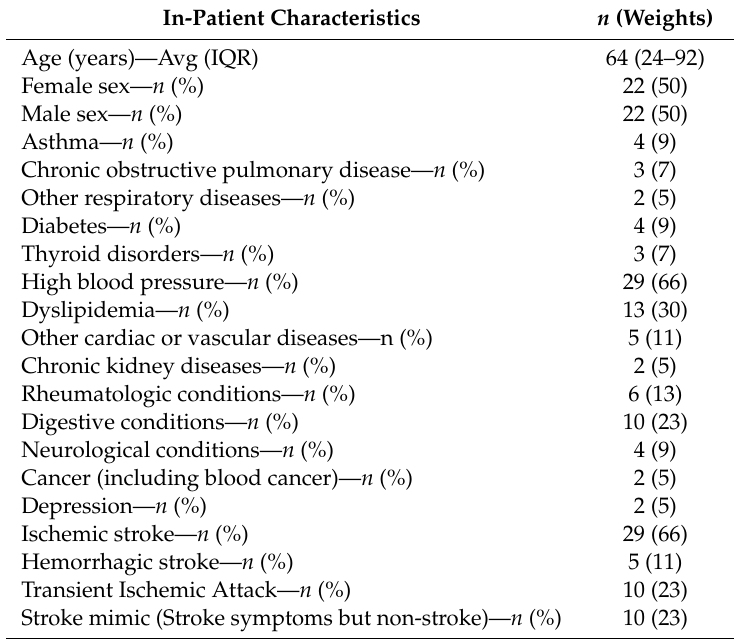
Table A2. In-patient characteristics ( n =